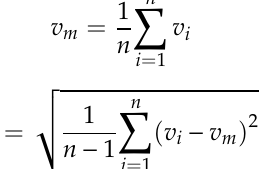
Figure 1. Monthly average wind speed for 10 m and 65 m hub heights.